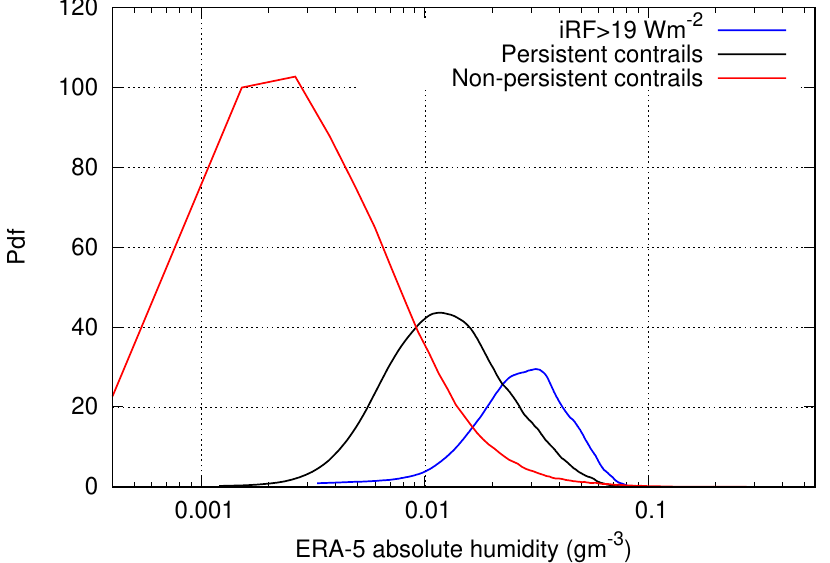
Figure 2. As Figure 1, but for absolute humidity in terms of water vapour mass concentration (in logarithmic